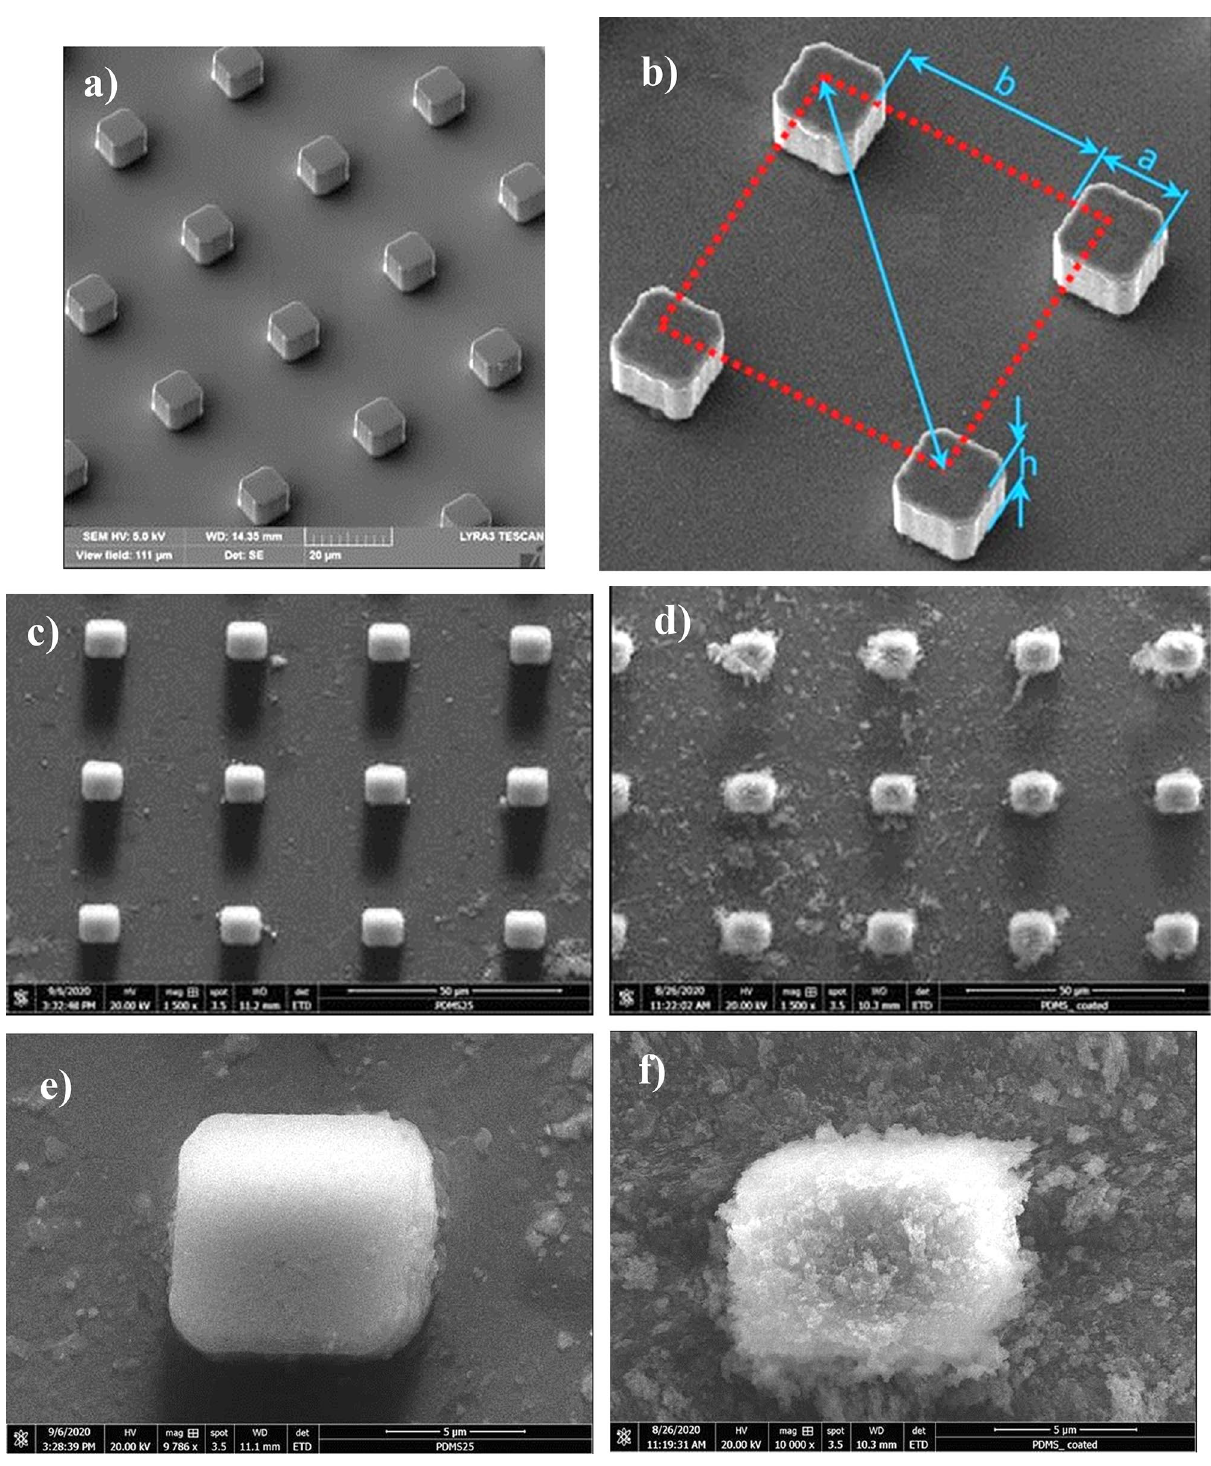
Figure 2. SEM micrographs of micro-post array surface: ( a ) micro-post on a silicon wafer, ( b ) micro-post sizing, ( c ) replicated micro-post on PDMS, ( d ) functionalized silica nanoparticles deposited replicated surface, ( e ) replicated single micro-post, and ( f ) functionalized silica nanoparticles deposited single micro-post and